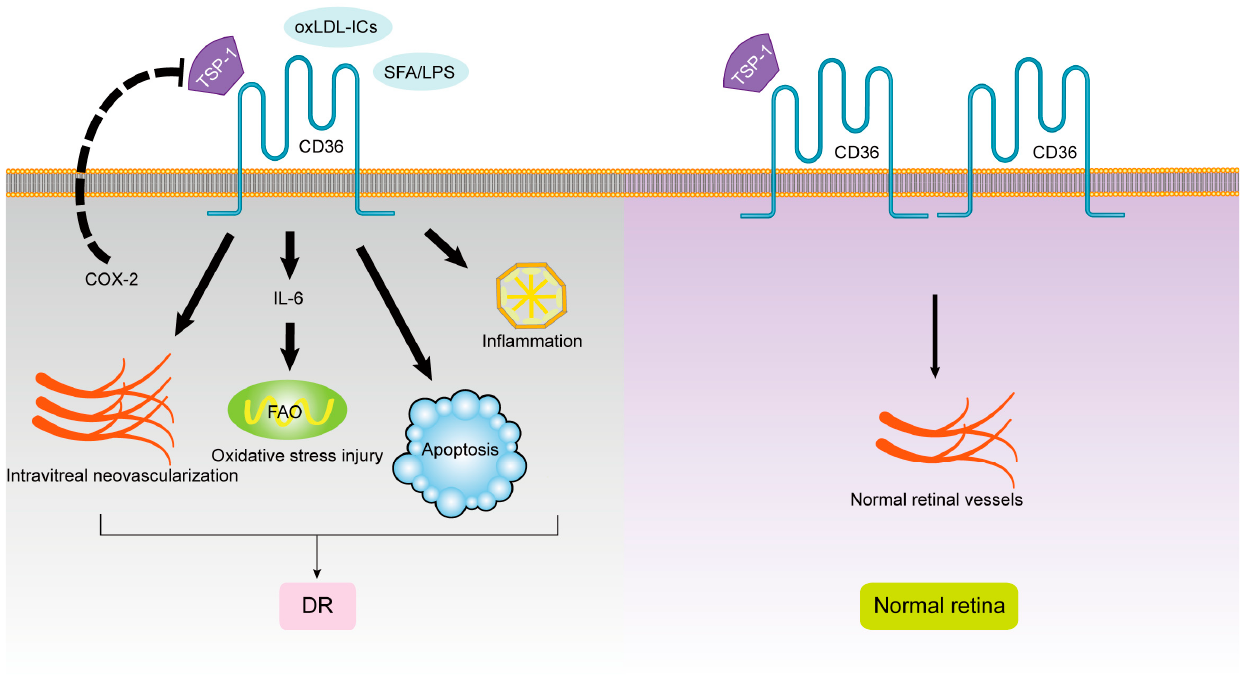
Figure 3. The roles of CD36 in